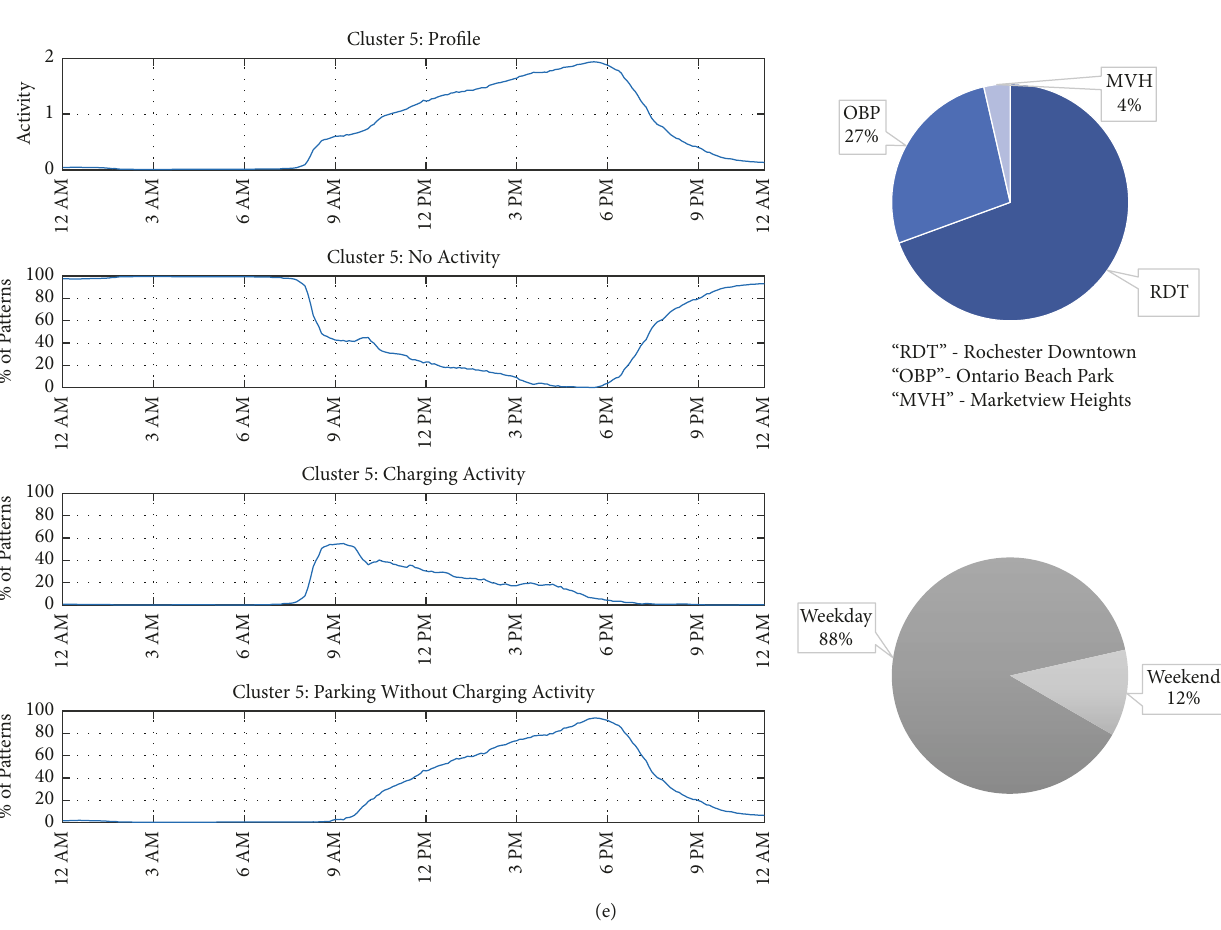
Figure 5: Cluster profiles and distribution of patterns in activities “0”—no activity, “1”—parking with charging, and “2”—parking without charging along with distribution of patterns with respect to location and type of day the pattern was observed (e.g., weekday of weekend) (a) Cluster 1, (b) Cluster 2, (c) Cluster 3, (d) Cluster 4, and (e) Cluster